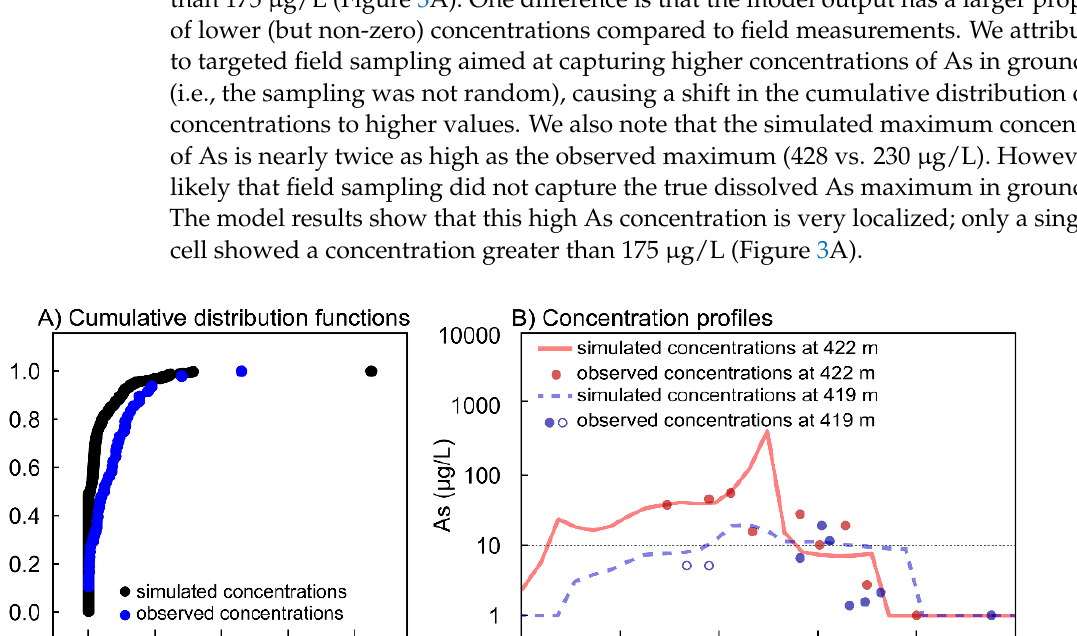
Figure 4. Model simulation results for solid phase concentrations of Fe(OH) 3 in 2016 (37 years after the oil spill). The gray box is the reference for the extent of the oil body. The top boundary is the water table. The effect of the “dual-zone” of Fe-reduction has confounding effects for As cycling. In the zone closest to the oil, As(V) initially complexed to Fe(OH) 3 (as Hfo_wAsO 42 − , and Hfo_wOHAsO 43 − ) is entirely stripped from sediment due to extensive Fe-reduction (Fig- ure 5), creating a plume of dissolved As (Figure 2D). This modeled depletion of As has been observed by chemical extractions of sediments collected from this zone [30]. How- ever, in the zone of partial Fe-depletion, sediments actually appear to be enriched in As via sorption of As(III) as Hfo_wH 2 AsO 3 (Figure 5C), despite the fact that Fe(III) is actively